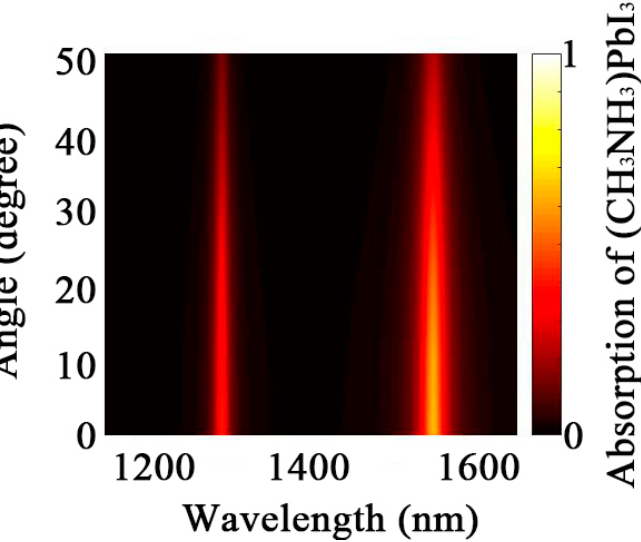
Figure 7. The absorption of (CH 3 NH 3 )PbI 3 as a function of angle and the wavelength of p -polarized incident light.